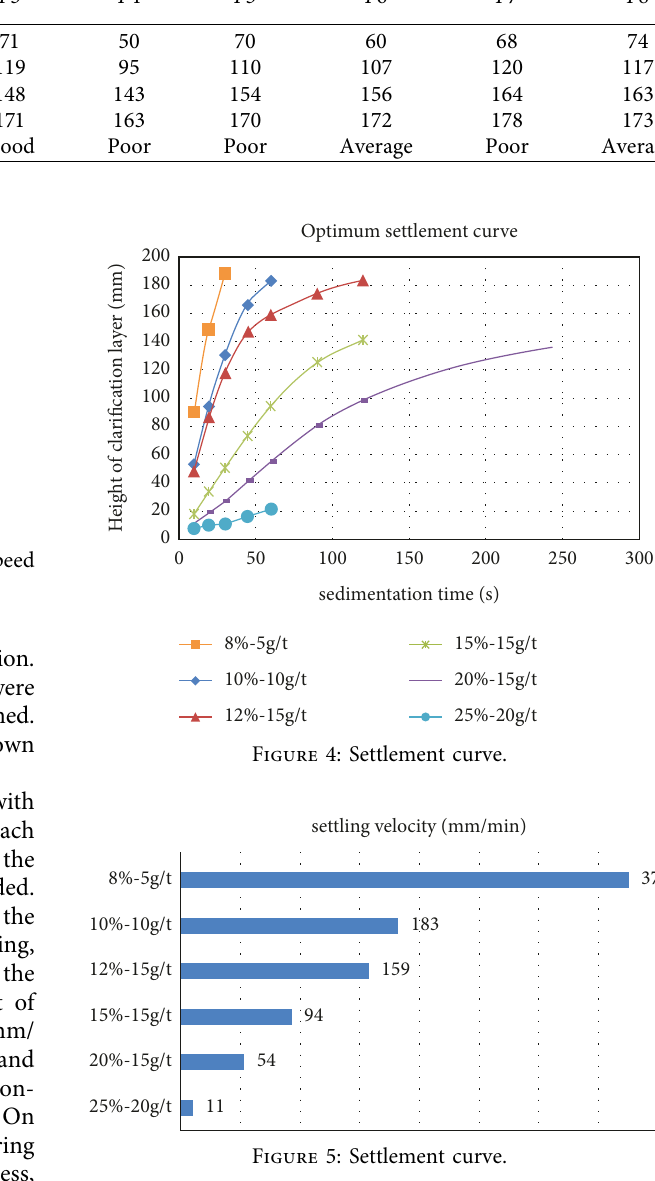
Table 2: Recording the height of the clarification layer for the flocculant test (unit: mm). Type